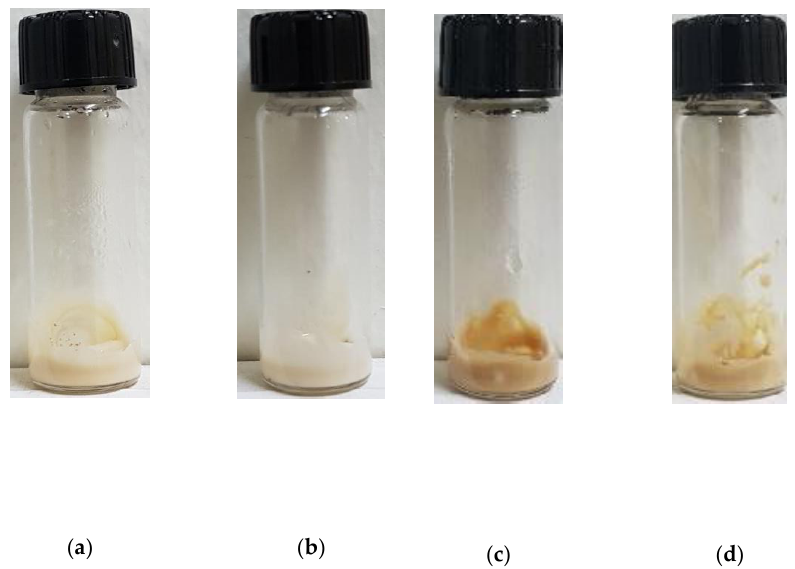
Figure 4. Appearance of the moisturizing cream blended with 1 wt % lignin: ( a ) CEL and ( b ) CEL-NP and with 5 wt % lignin: ( c ) CEL and ( d ) CEL-NP.